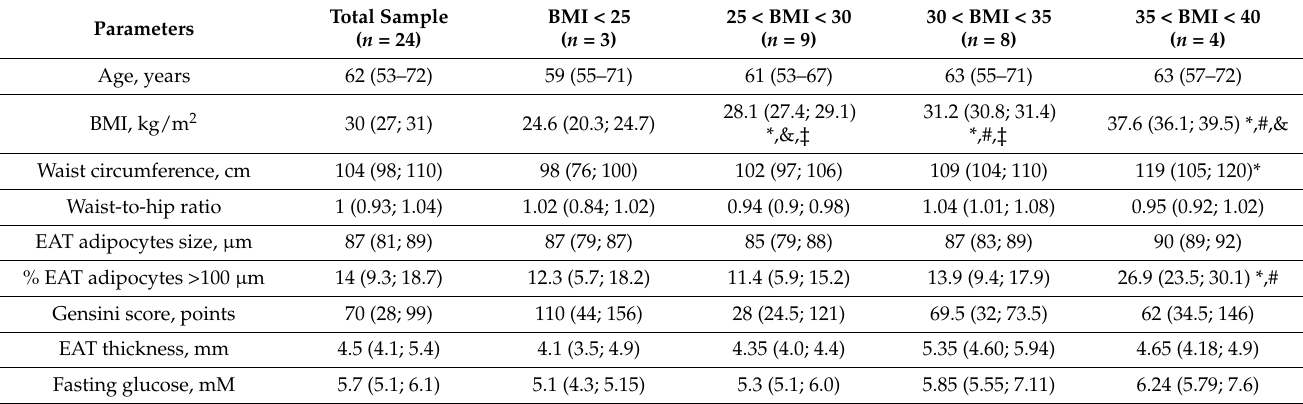
Table 3. Clinical characteristics of CAD patients depending on